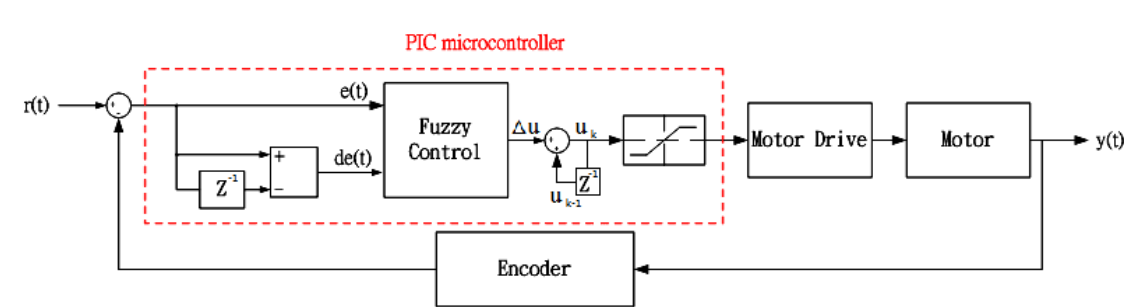
Figure 7. The control system block diagram.